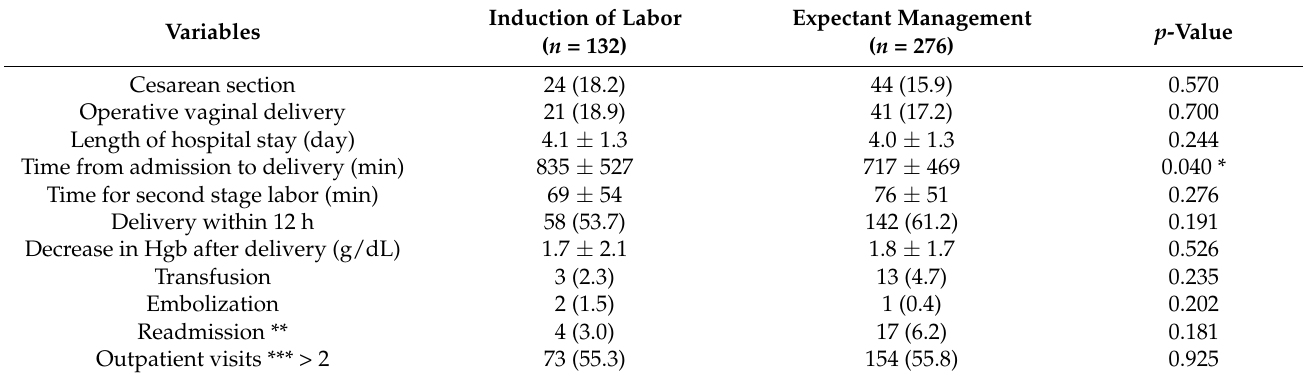
Table 2. Obstetrics and maternal outcomes of induced labor and expectant management.